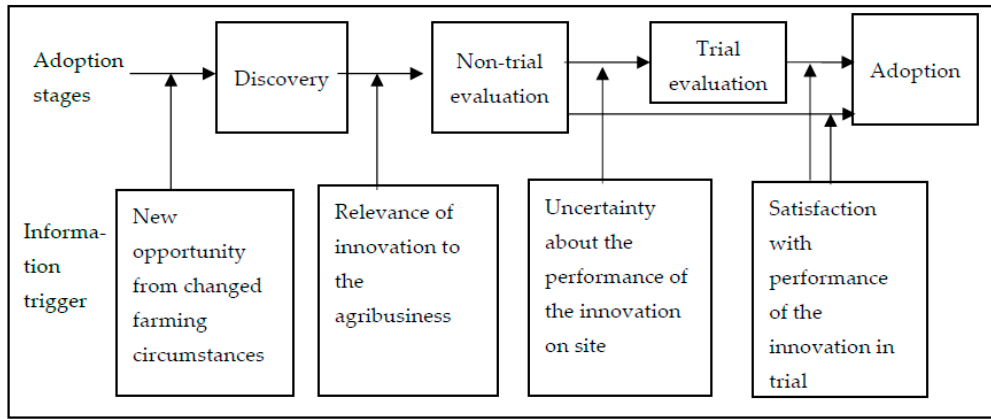
Figure 4. Information flow conceptual model. Based on Lindner et al.